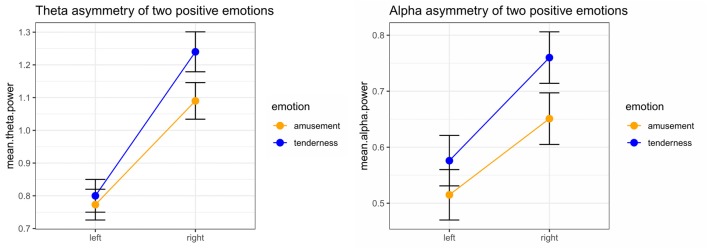
Significant emotion category × hemisphere interactions for the mean power values of theta and the theta band at the Fleft/Fright site between amusement and tenderness.